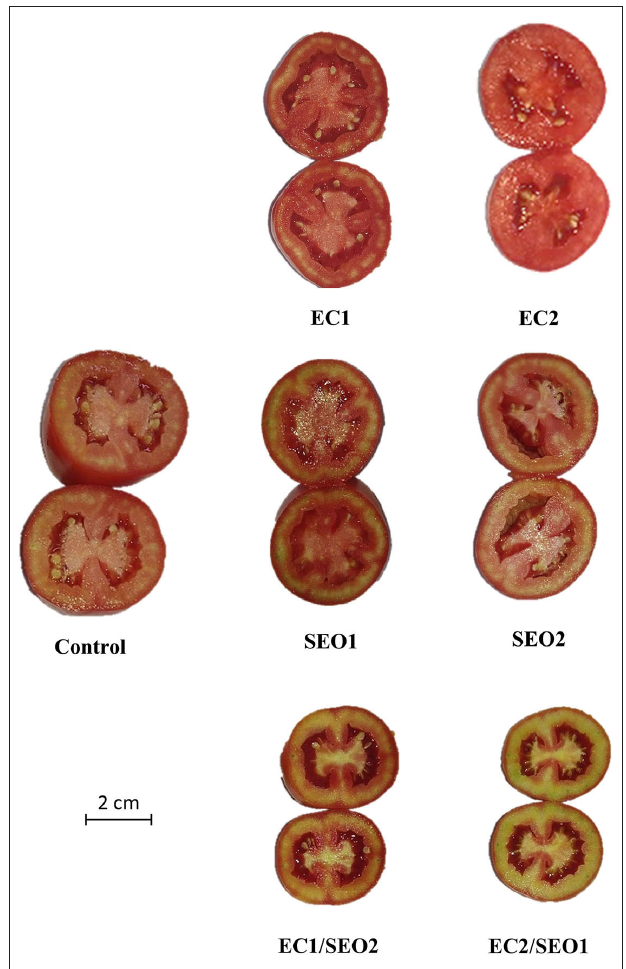
FIGURE 2 | Transverse sections of tomato fruits under control (C, 0.4 dS/m), saline (EC1, 3.5 dS/m; EC2, 7 dS/m), spent engine oil stress (SEO1, 0.5%; SEO2, 1%) and the combinations (EC1/SEO2, 3.5 dS/m EC/1% SEO; EC2/SEO1, 7 dS/m EC/0.5% SEO).